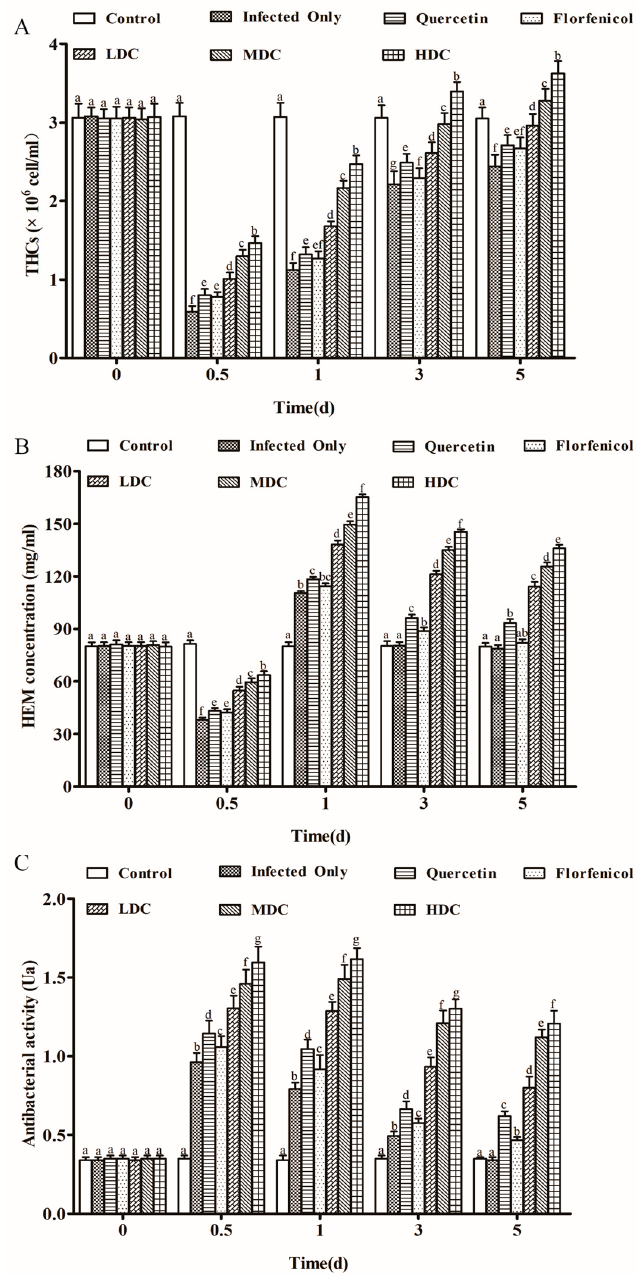
Figure 3. The THC levels ( A ), HEM levels ( B ), and antibacterial activity ( C ) in L. vannamei at different times following drug treatment. One-way ANOVA and Duncan’s multiple range test were used to analyze the significant differences among different groups, and different letters represent significant differences between groups ( p < 0.05).